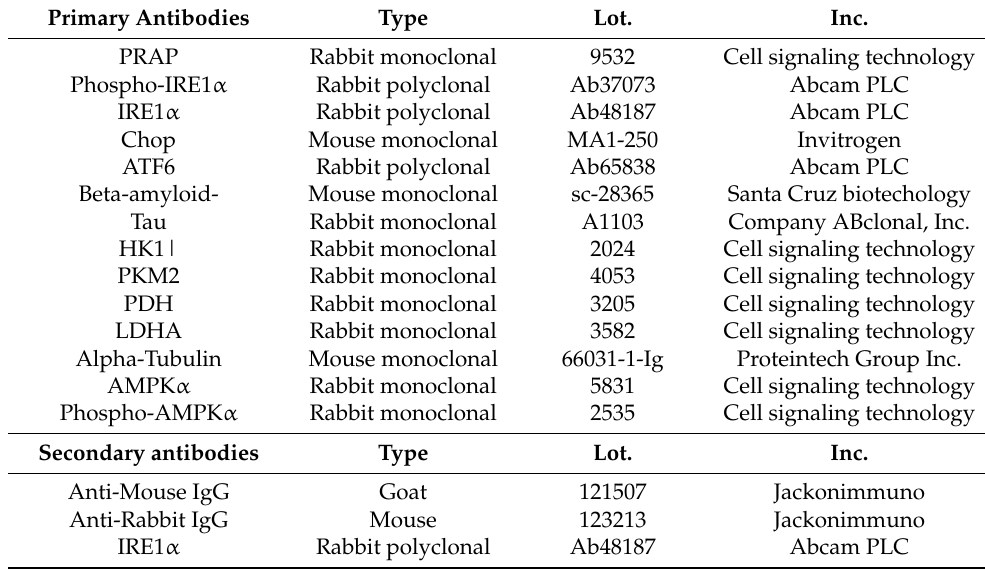
Table 1. Primary and secondary antibodies used for Western